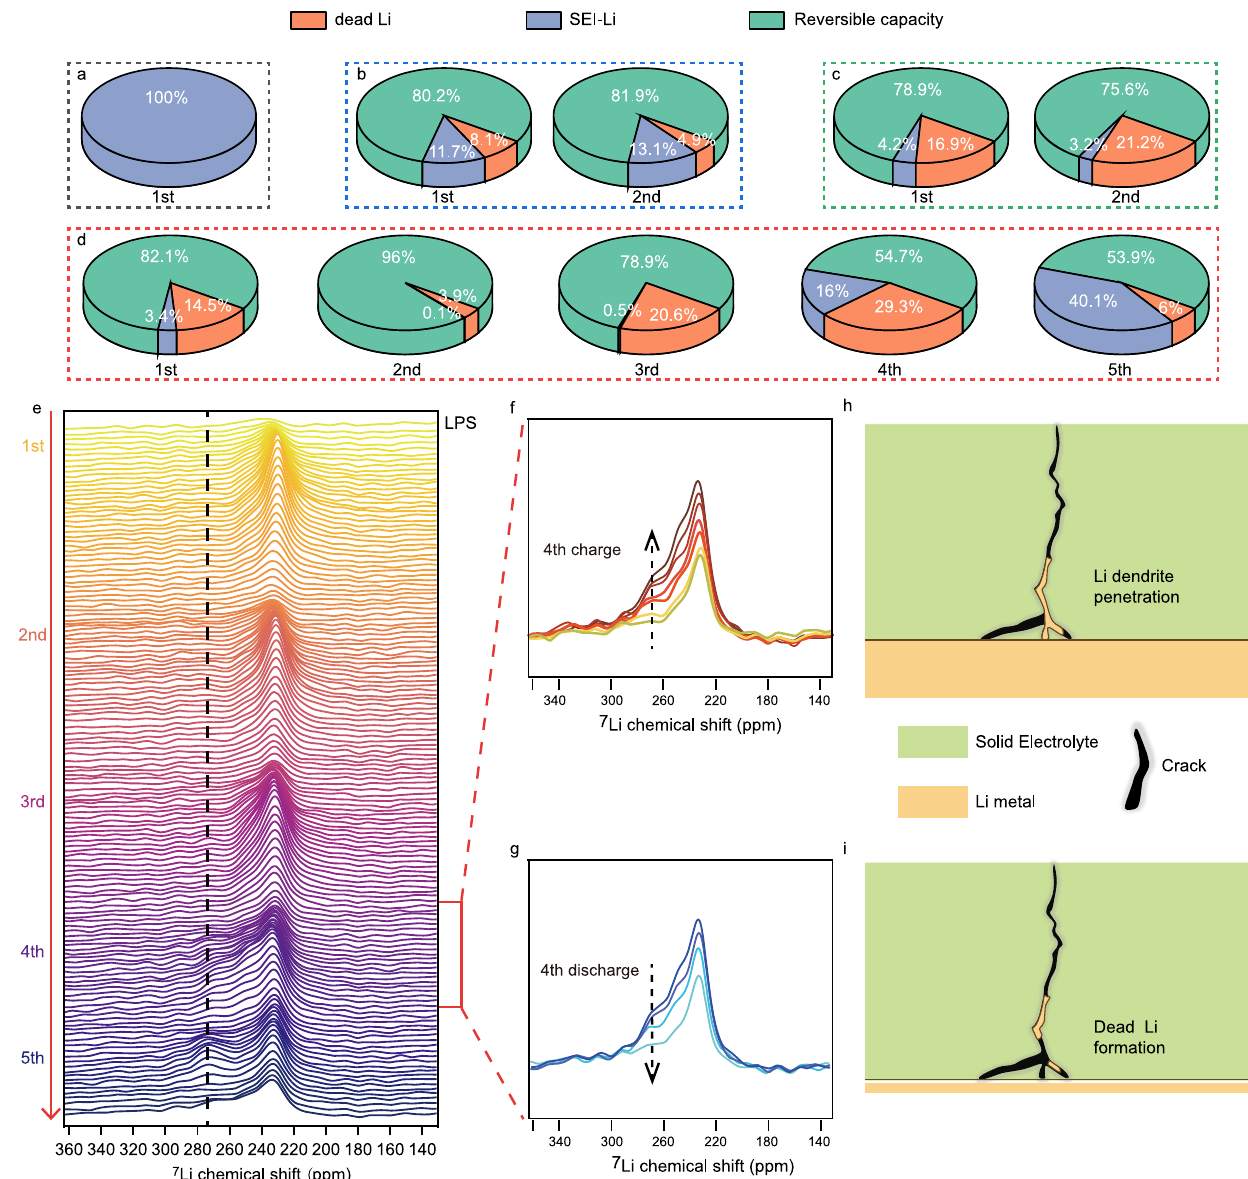
Fig. 4 | Quantitative and quanlitative analysis of operando 7 Li NMR spectra of SSBs.a – d Thecalculated relative ratio of reversiblecapacity, deadLiand SEI-Lifor cellsassembledusingLGPS( a ),LSiPSCl( b ),LPSCl( c ),andLPS( d ). e – g operando 7 Li NMR stack spectraof AFB (with LPS) during the fi rst fi ve cycles ( e ), with magni fi ed